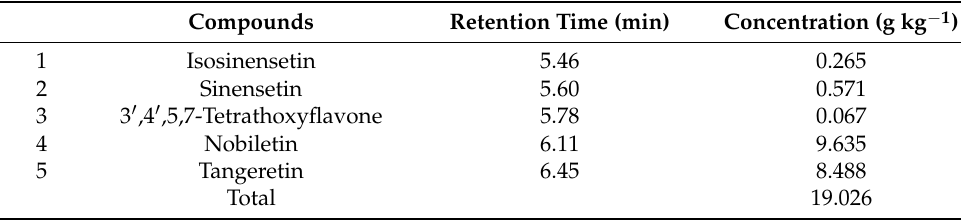
Table 1. Major chemical compounds of PMFs dissolved in